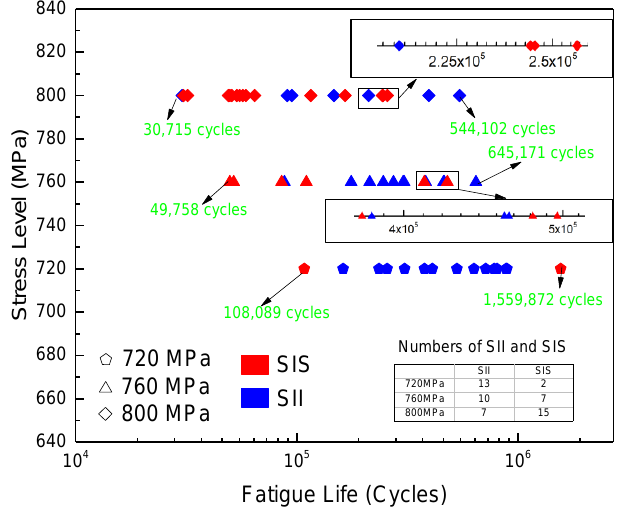
Figure 6. Fatigue life data under three stress levels.